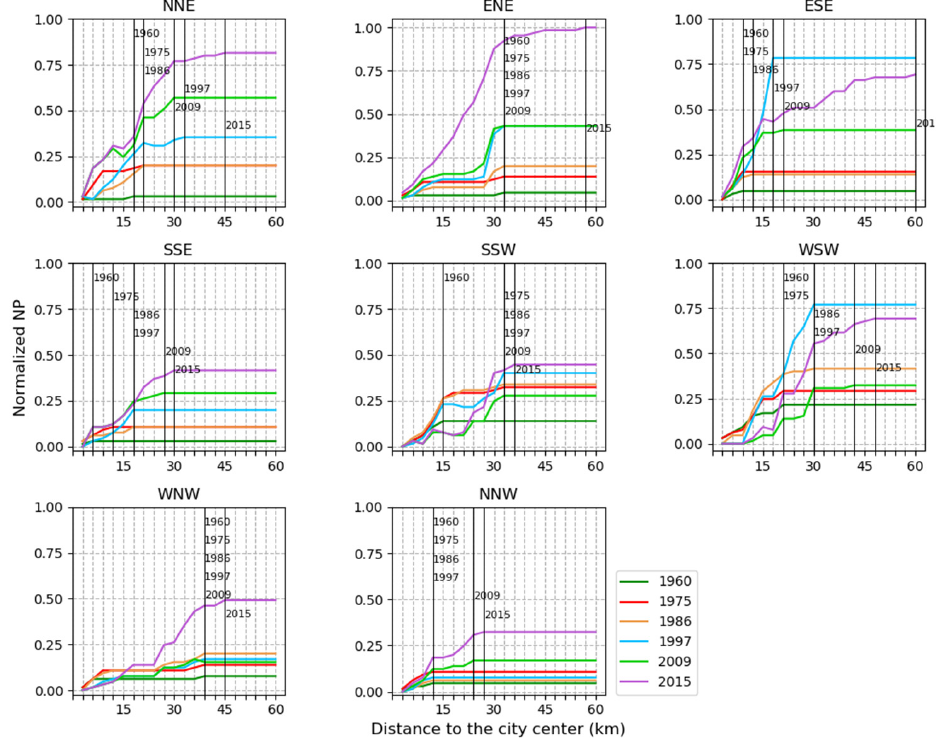
Figure 5. The number of urban patches in different directions and within concentric rings from 1960 to 2015. The x-axis represents the distances to the city center. The y-axis represents the normalized value of the metric. The black vertical line represents the distance where the metric value became stable for each year.